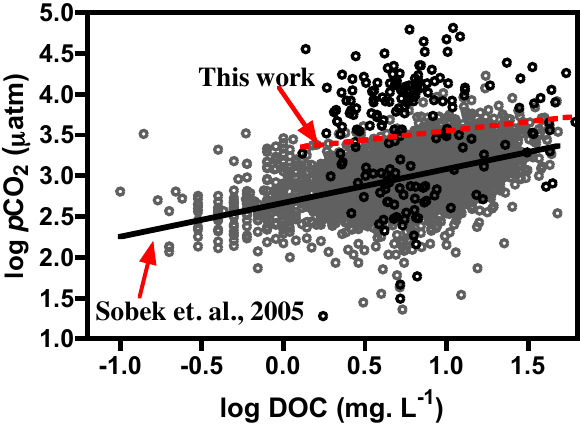
Figure 3. Comparisons of p CO 2 against DOC concentrations for lakes from this study (black circles) and from Sobek et al. (2005; gray circles). Each point in the plot represents one measurement. The dashed line represents the linear regression for all Brazilian data points (not significant; p >0.05), and the solid line represents the linear regression from Sobek et al. (2005; p <0.05, R 2 = 0.26, log p CO 2 (µatm) = 2.67 + 0.414logDOC; mgCL − 1 )